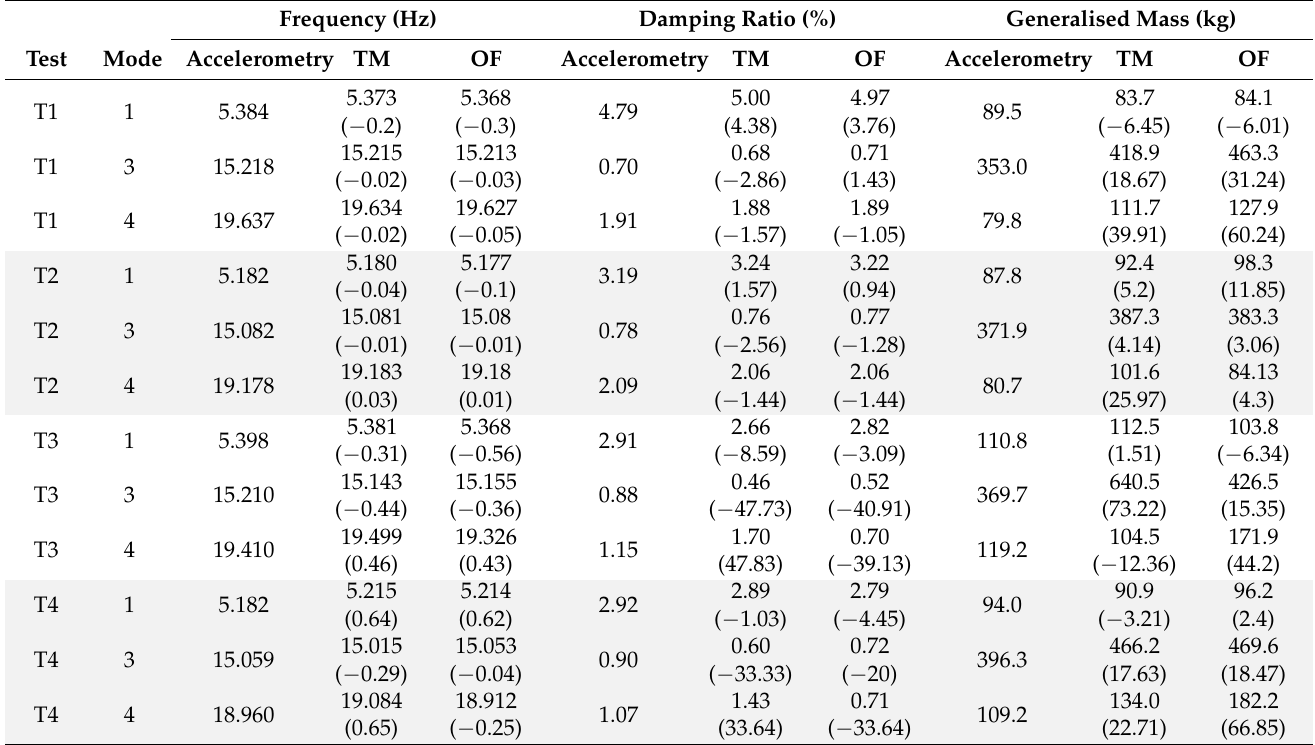
Table 3. Modal properties. Values in brackets denote percentage error relative to the results from accelerometry. Damping Ratio